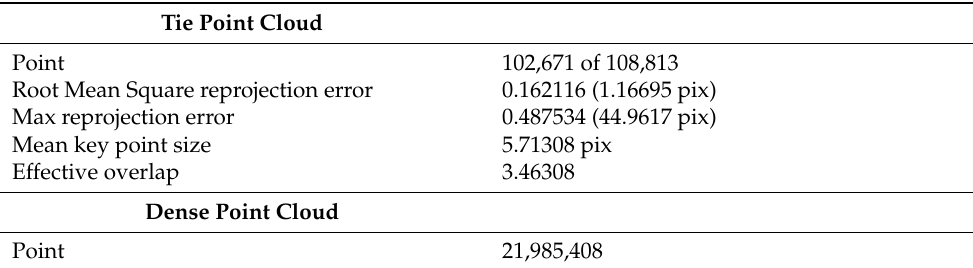
Table 3. Detected tie point and generated dense point